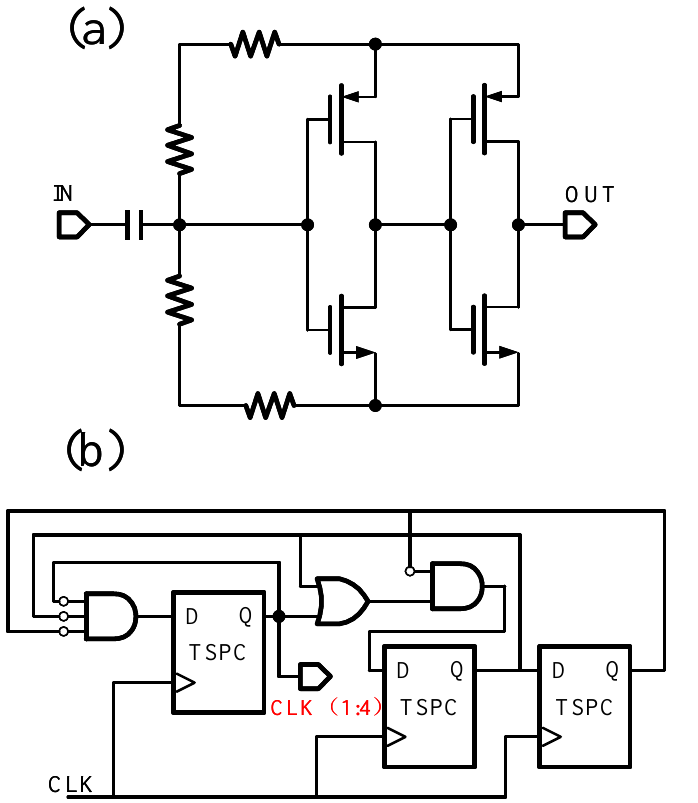
Figure 5. ( a ) The schematic of the sinusoidal-to-square wave transform circuit, ( b ) The diagram of the one-fifth frequency